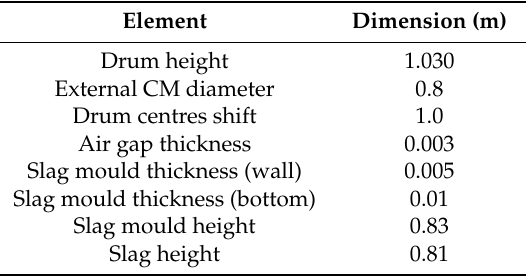
Table 1. Main dimensions of the drum.